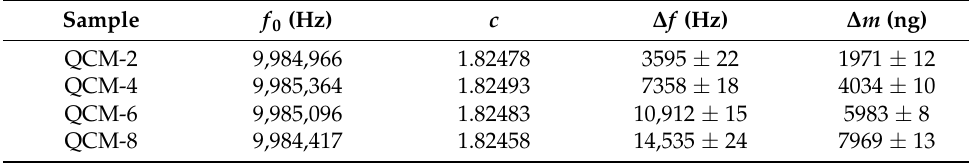
Table 1. The MOF mass deposited on the active region of the QCM